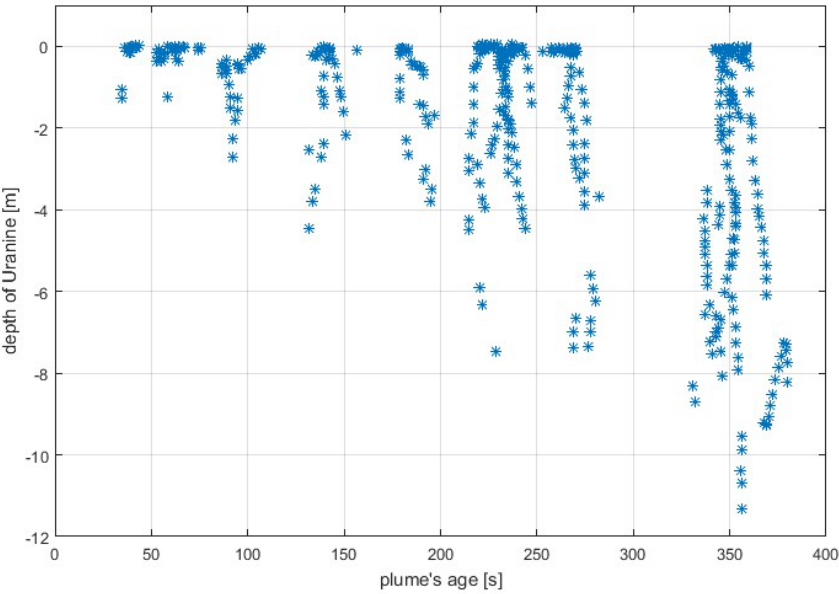
Figure 6. Depth of the AUV (as in Figure 5b) versus effective plume’s age (as in Figure 5d) shown only for the instances with Uranine signal (Figure 5e) above noise level. The figure demonstrates the vertical entrainment of the dye (initially sprayed on the surface) by downward jets at a rate of ≈3